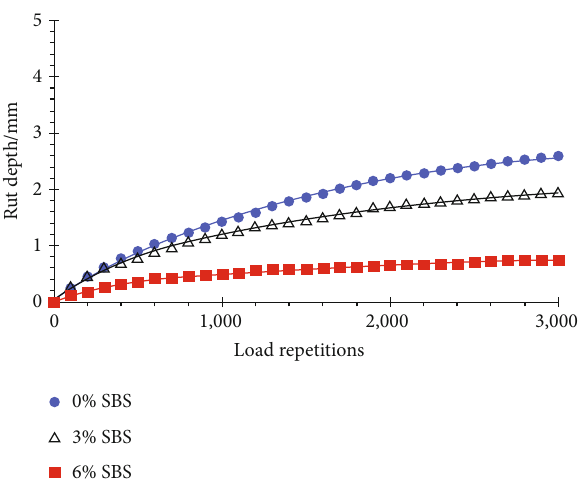
Figure 8: Rut depth results of laboratory specimens